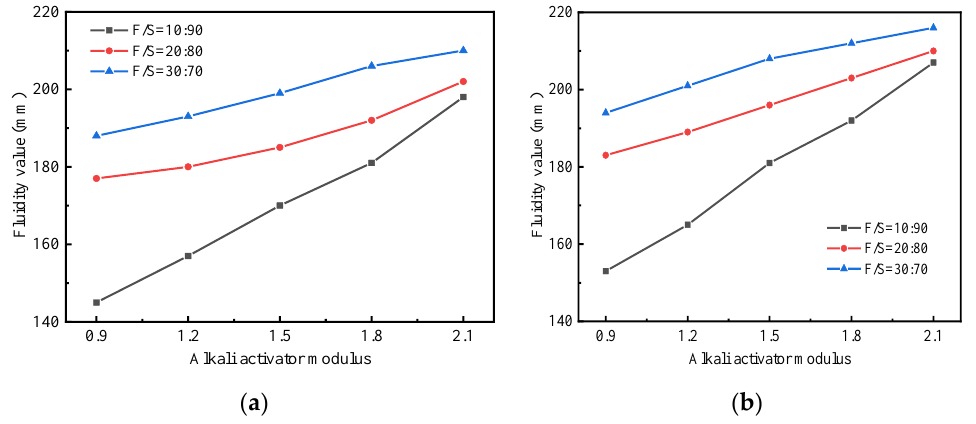
Figure 3. Fluidity of stabilized soil: ( a ) One-step method. ( b ) Two-step method.